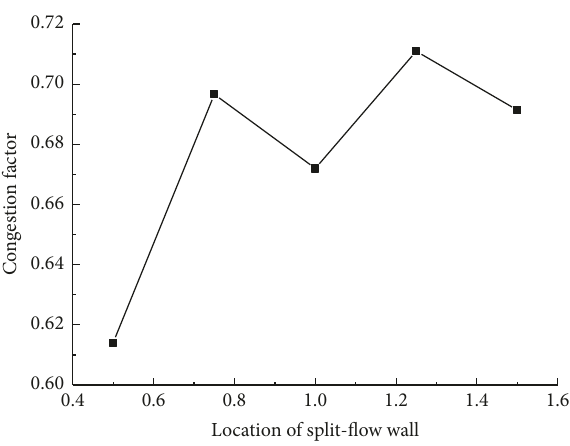
Figure 15: Evacuation time when 𝐷 = 2 , 𝐿 = 1.5